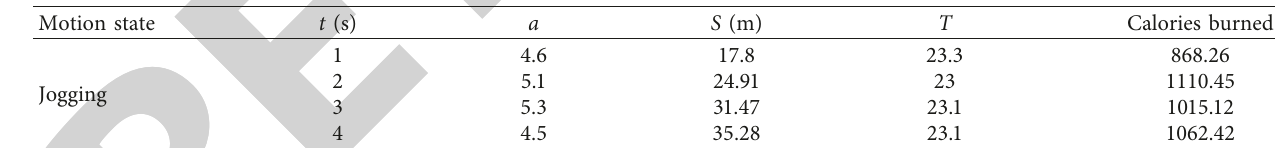
Table 4: Experimental test results of jogging.